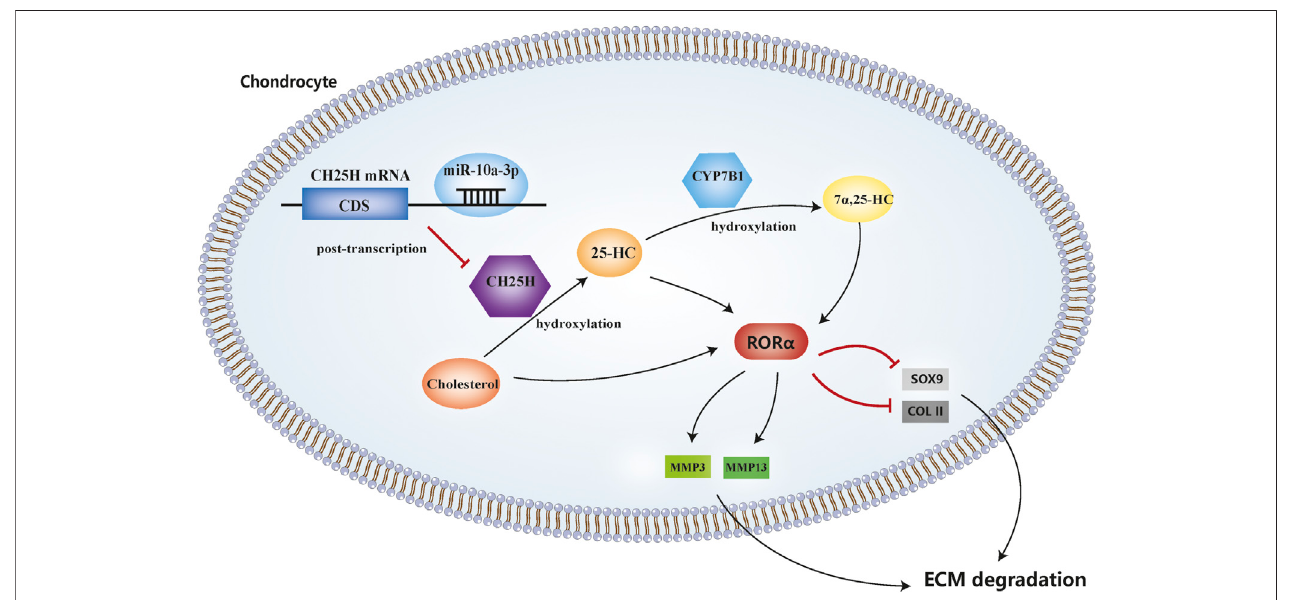
FIGURE 7 | MicroRNA-10a-3p improves ECM degeneration by regulating CH25H-CYP7B1-ROR α mediated cholesterol metabolism in osteoarthritic chondrocytes.